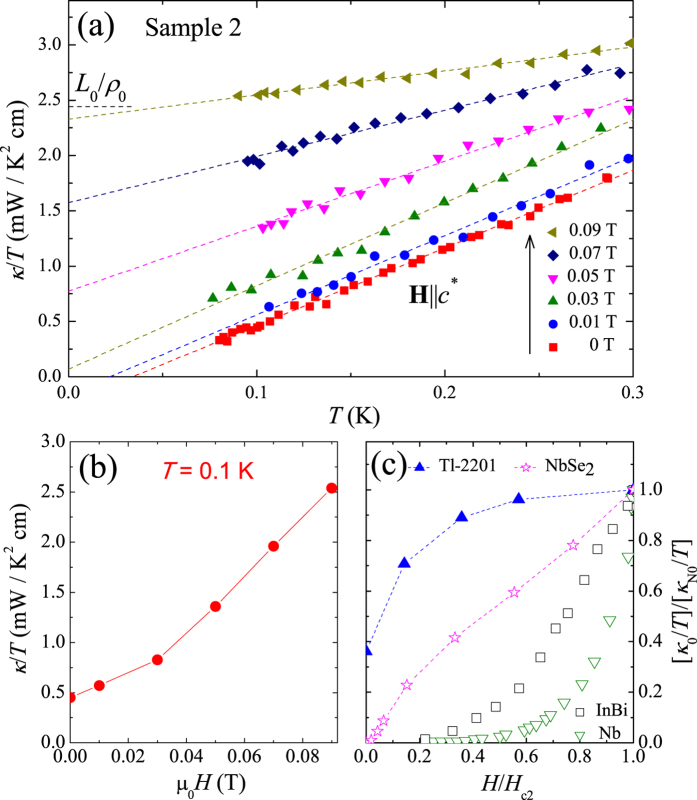
Low-temperature thermal conductivity data.(a) Low-temperature thermal conductivity of Ta3Pd3Te14 crystal (Sample 2) in zero and magnetic fields applied along c* direction. The dashed lines are fits to the formula κ/T = κ0/T + bT. The black dashed line is the normal-state Wiedemann-Franz law expectation L0/ρ0. (b) The field dependence of κ/T at 0.1 K. (c) Normalized residual linear term κ0/T as a function of normalized field H/Hc2 for the clean s-wave superconductor Nb36, the dirty s-wave superconducting alloy InBi32, the multi-band s-wave superconductor NbSe237, and an overdoped d-wave cuprate superconductor Tl-220138.